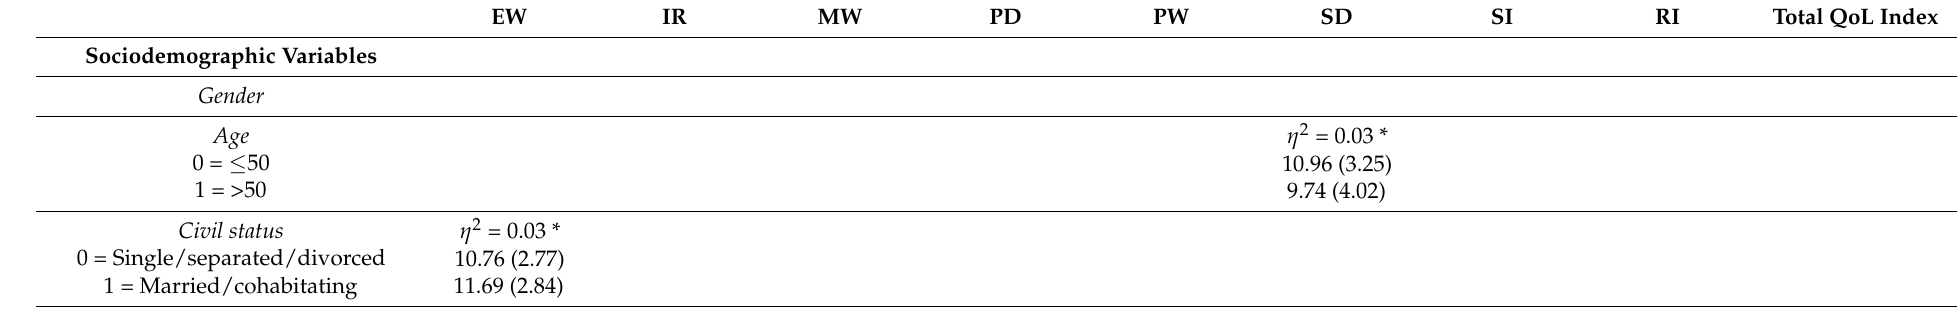
Table 4. Parametric test results for QoL’s domains and total score one-year